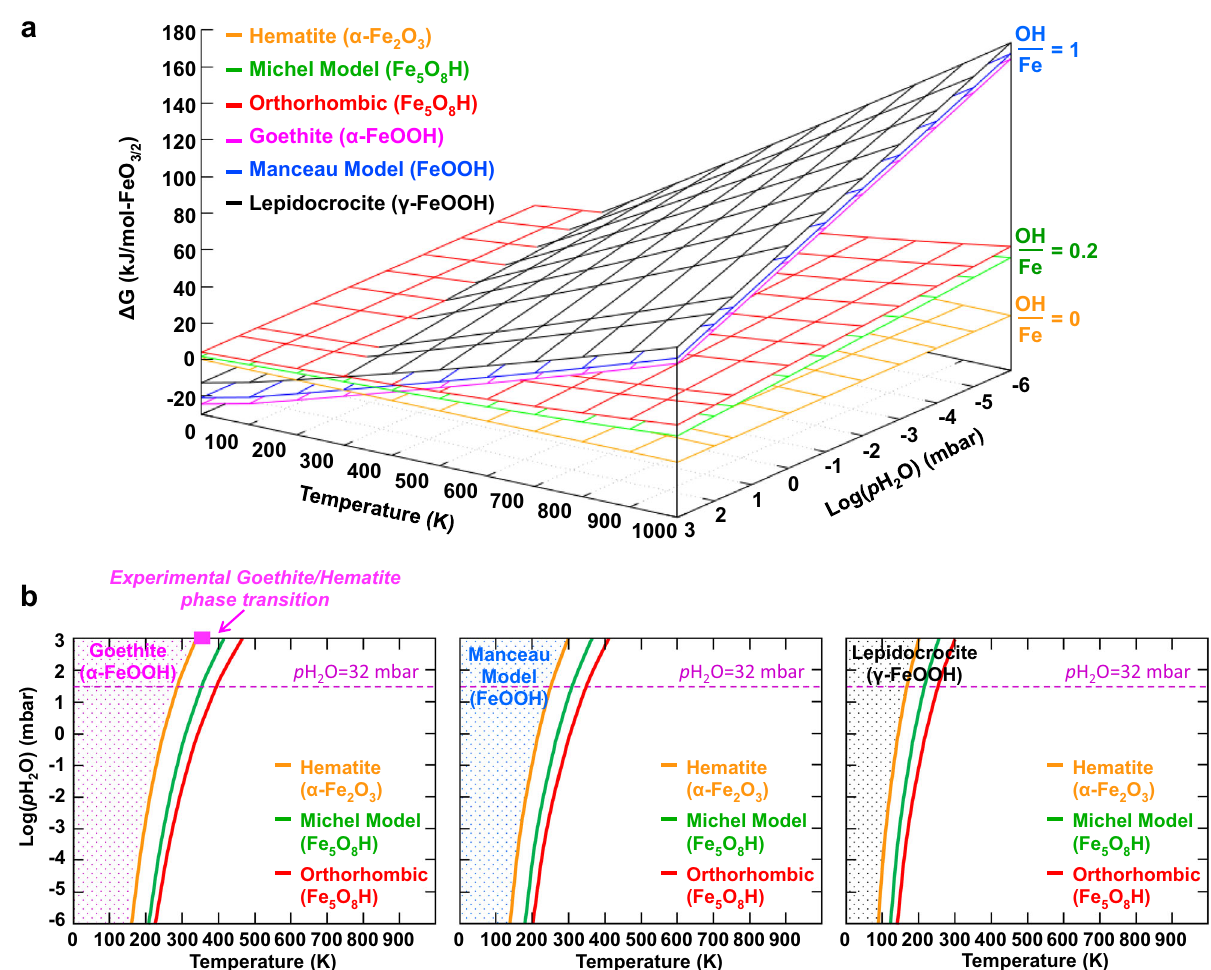
Fig. 3 Relative phase stability of mineral phases. Calculated relative bulk phase stabilities for hematite, goethite, lepidocrocite, the two ferrihydrite models, and the orthorhombic structure. a 3D plot of the Gibbs free energy as a function of the temperature and water partial pressure. b Water pressure- temperature phase diagrams showing the domain of stability for each phase and the conditions at various phase boundaries. The purple dashed line indicates the water pressure for which p H 2 O = 32 mbar. The color dotted areas highlight the ( T , P ) conditions at which each FeOOH phase is the most thermodynamically